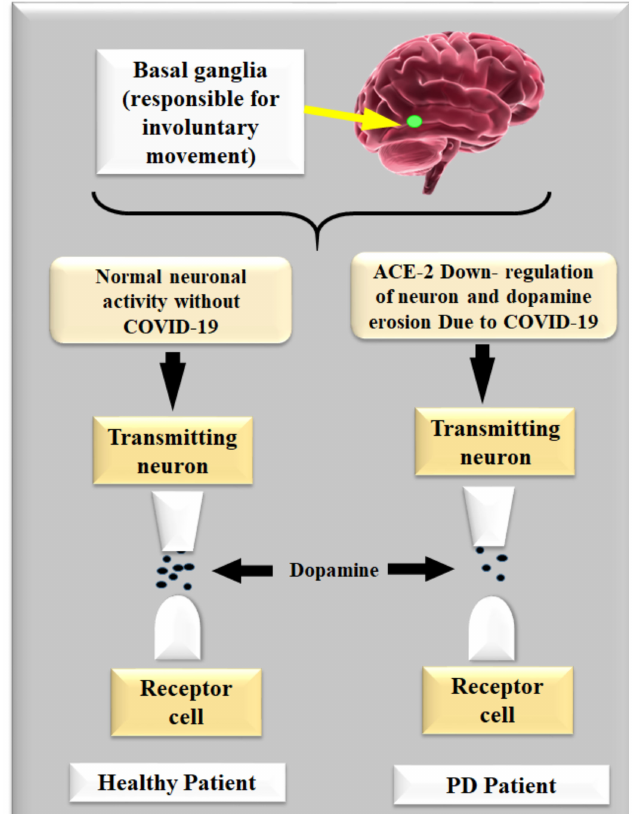
Figure 5. Effect of loss of dopamine in PD with or without COVID-19 (Courtesy of AtheroPoint, Roseville, CA,